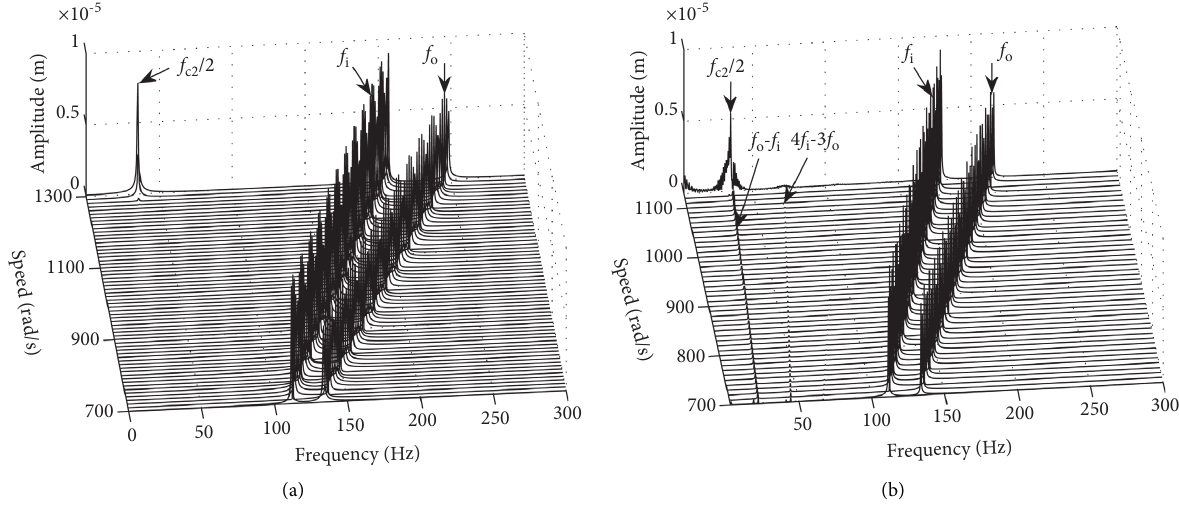
Figure 19: Waterfall plots of the MSDS with K